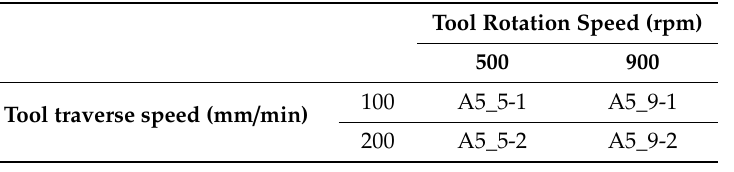
Table 3. Summary of Welding Matrix.